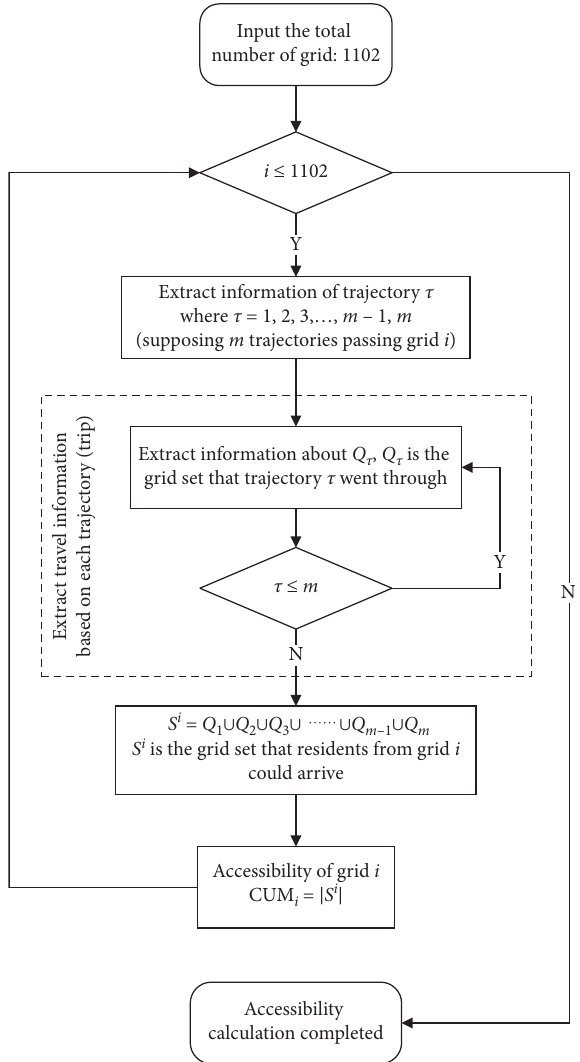
Figure 5: Accessibility calculation